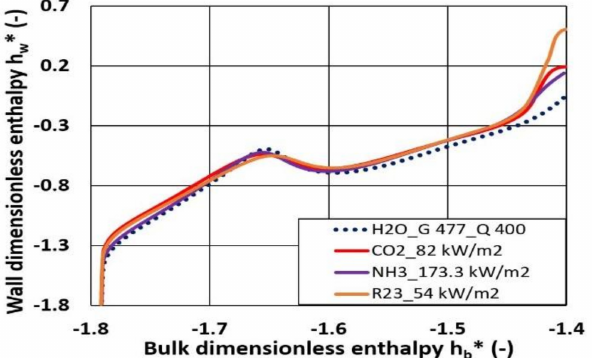
Figure 12. Predictions with the best heat fluxes for Watts’ data (Reference Case: G = 477 kg/m 2